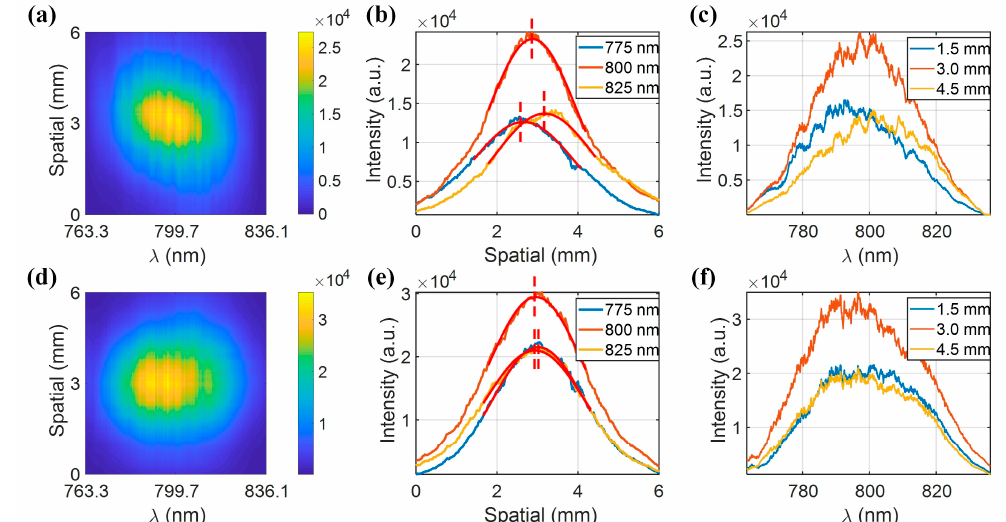
Figure 6. The vertical chirp of the stretched pulses measured with an imaging spectrometer. ( a ) The spectrum corresponding to a vertical line of the light spot with a large vertical chirp; ( b ) the spatial profiles corresponding to three different wavelengths in ( a ), in which the centers show an obvious shift in vertical direction; ( c ) the spectrum corresponding to three different positions in ( a ), in which profiles also have an obvious shift; ( d , e ) the spatial-spectrum of an output pulse when the stretcher is well adjusted, which show little shift both in the spatial profiles and spectrum profiles, indicating the pulse has little vertical chirp.